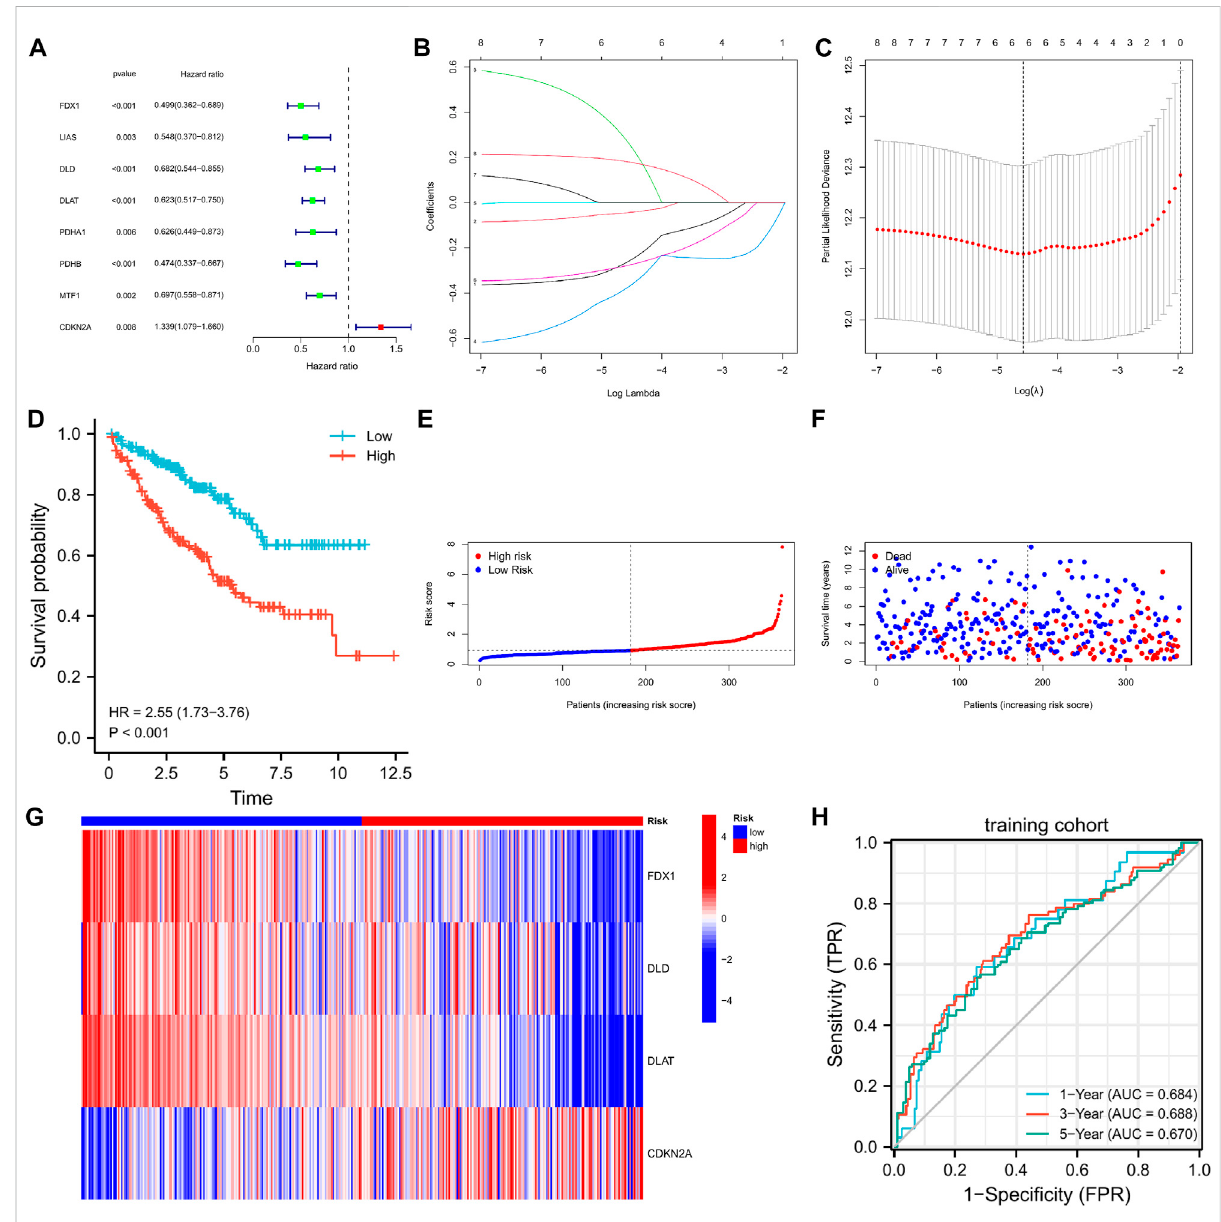
FIGURE 3 The4-CRGsrisksignatureinthetrainingcohort. (A) TheCRGswithprognosticvalueswereassessedbytheunivariateCoxproportionalhazards regressionmodelinthetraining cohort. (B,C) The selection ofCRGs for risksignaturebyLASSOanalysisinthetraining cohort. (D) K-McurvesforOS in the training cohort. (E – G) The risk score, survival status, and heatmap of 4 CRGs in the training cohort. (H) Time-dependent ROC curves for OS in the training